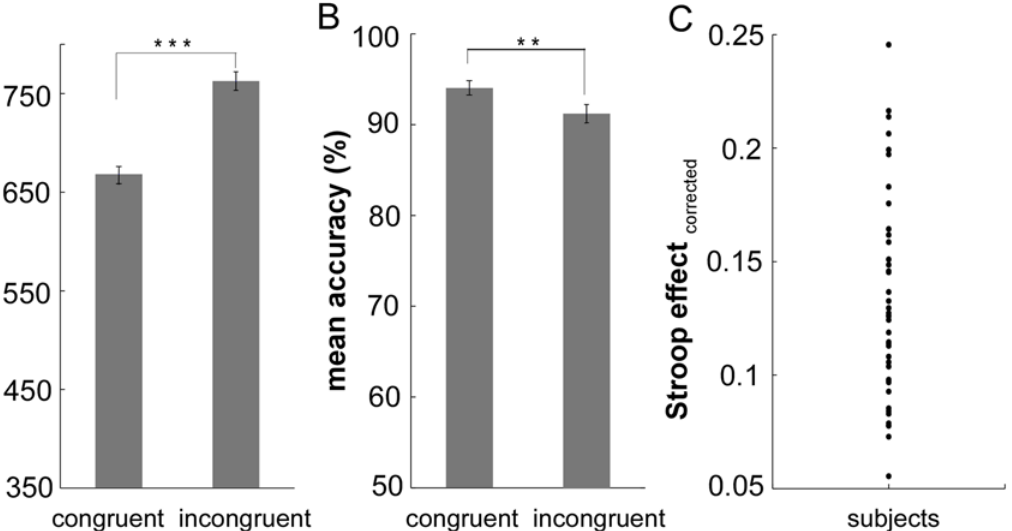
Fig 1. The behavioral results. Pane lA illustrates the mean RT as a function of congruency (C, I). It indicates a significant Stroop effect (I-C), with some subjects exhibiting a larger Stroop effect than others. Pane lB illustrates that the mean accuracy rate as a function of congruency (C, I). Error bars represent standard errors, respectively. N = 41. RT = response time. ( *** P < 0.001; * * P < 0.01). Pane lC represents individual differences related to Stroop effect (ratio of Stroop effect over mean RT). Note: each circle represents a subject ’ s Stroop effect score.